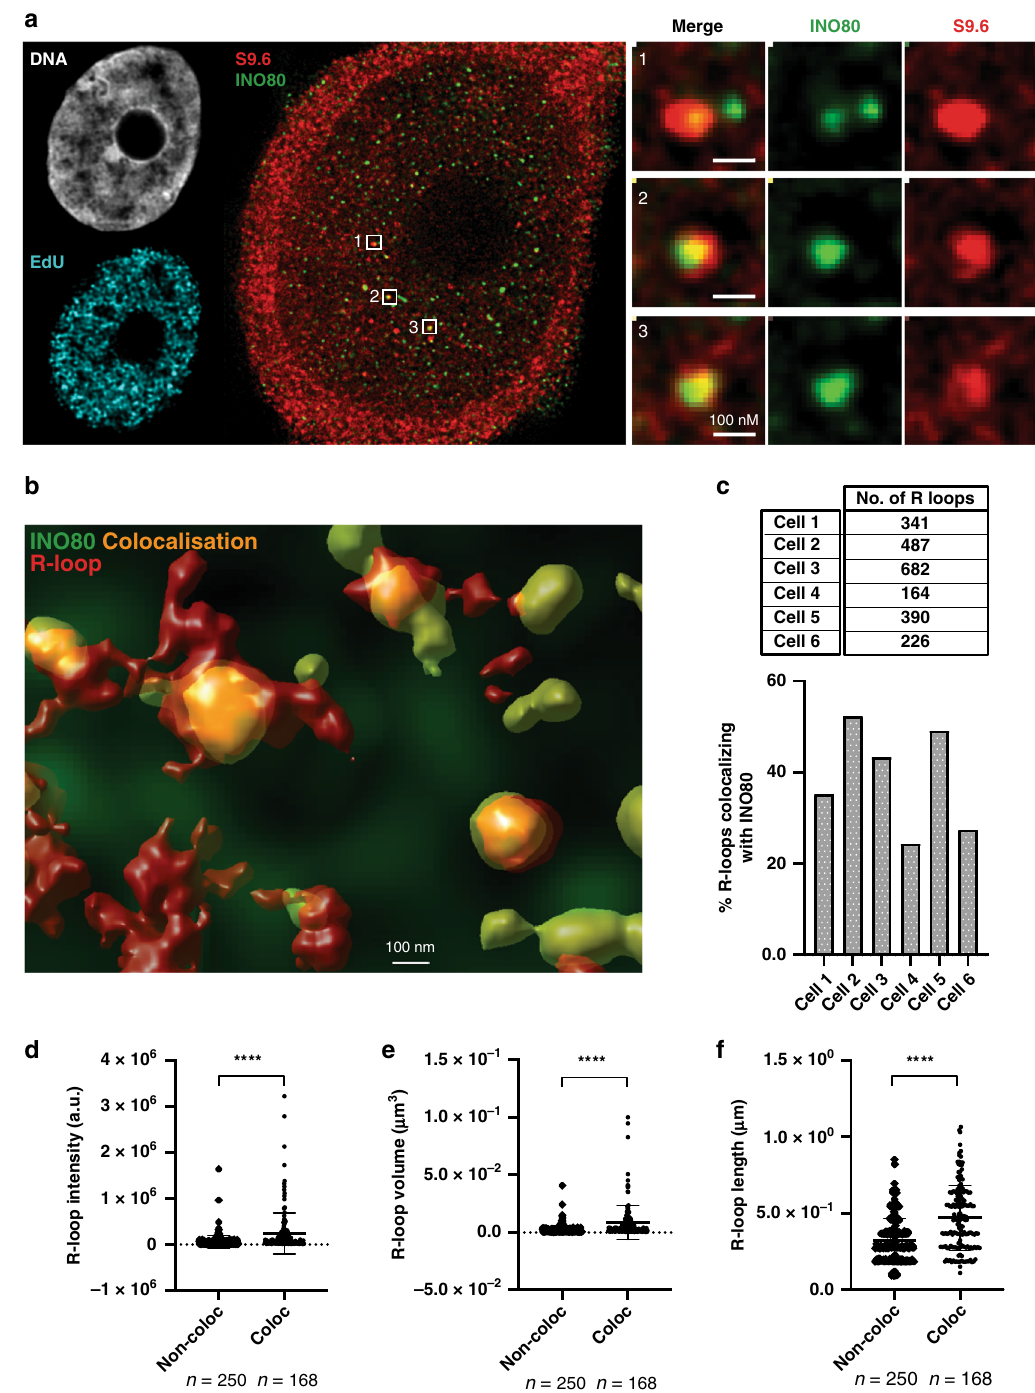
Fig. 5 Colocalization of INO80 with R-loops by STED nanoscopy. a Single image plane of confocal and STED imaging of PC3 cells. Cells were pulsed with EdU for 15 ′ and immunostained with S9.6 and anti-INO80 antibodies and imaged using confocal (EdU) and STED (INO80 and S9.6). STED imaging pixel size is 11 nm in XY. Panel 1, 2 and 3 are magni fi ed regions where INO80 and S9.6 co-localize. Scale bar = 100 nm n = 6 independent cells were analysed from three replicates b 3D volume surface model of INO80 and S9.6. Transparency of the INO80 volume (green) has been increased to enable visualization of overlapping regions (yellow). Similar results were obtained from six independent cells. c Upper panel. The number of R-loops per cell was determined in six independent EdU positive cells. Thresholds were generated based on fl uorescence intensity within the Hoechst stained nuclear volume and excluded objects that were below 10 voxels in size as background. The number of R-loops (S9.6 volumes) which shared co-localizing voxel volumes with INO80 were quanti fi ed. Lower panel. Bar-graph indicating the percent of R-loops colocalizing with INO80 relative to the total amount of R-loops in each cell. d – f Comparative analysis of R-loop intensity sum d , voxel volume e and length f in colocalizing (coloc) or non-colocalizing (non-coloc) with INO80 in Cell 1 n = 250 non co-localising R-loops, n = 168 colocalising R-loops. (****adjusted p -value < 0.0001; one way ANOVA). Analysis of the cells 2 – 6 is in Supplementary Fig. 9. Data are presented as mean values ± Standard deviation (SD) ”